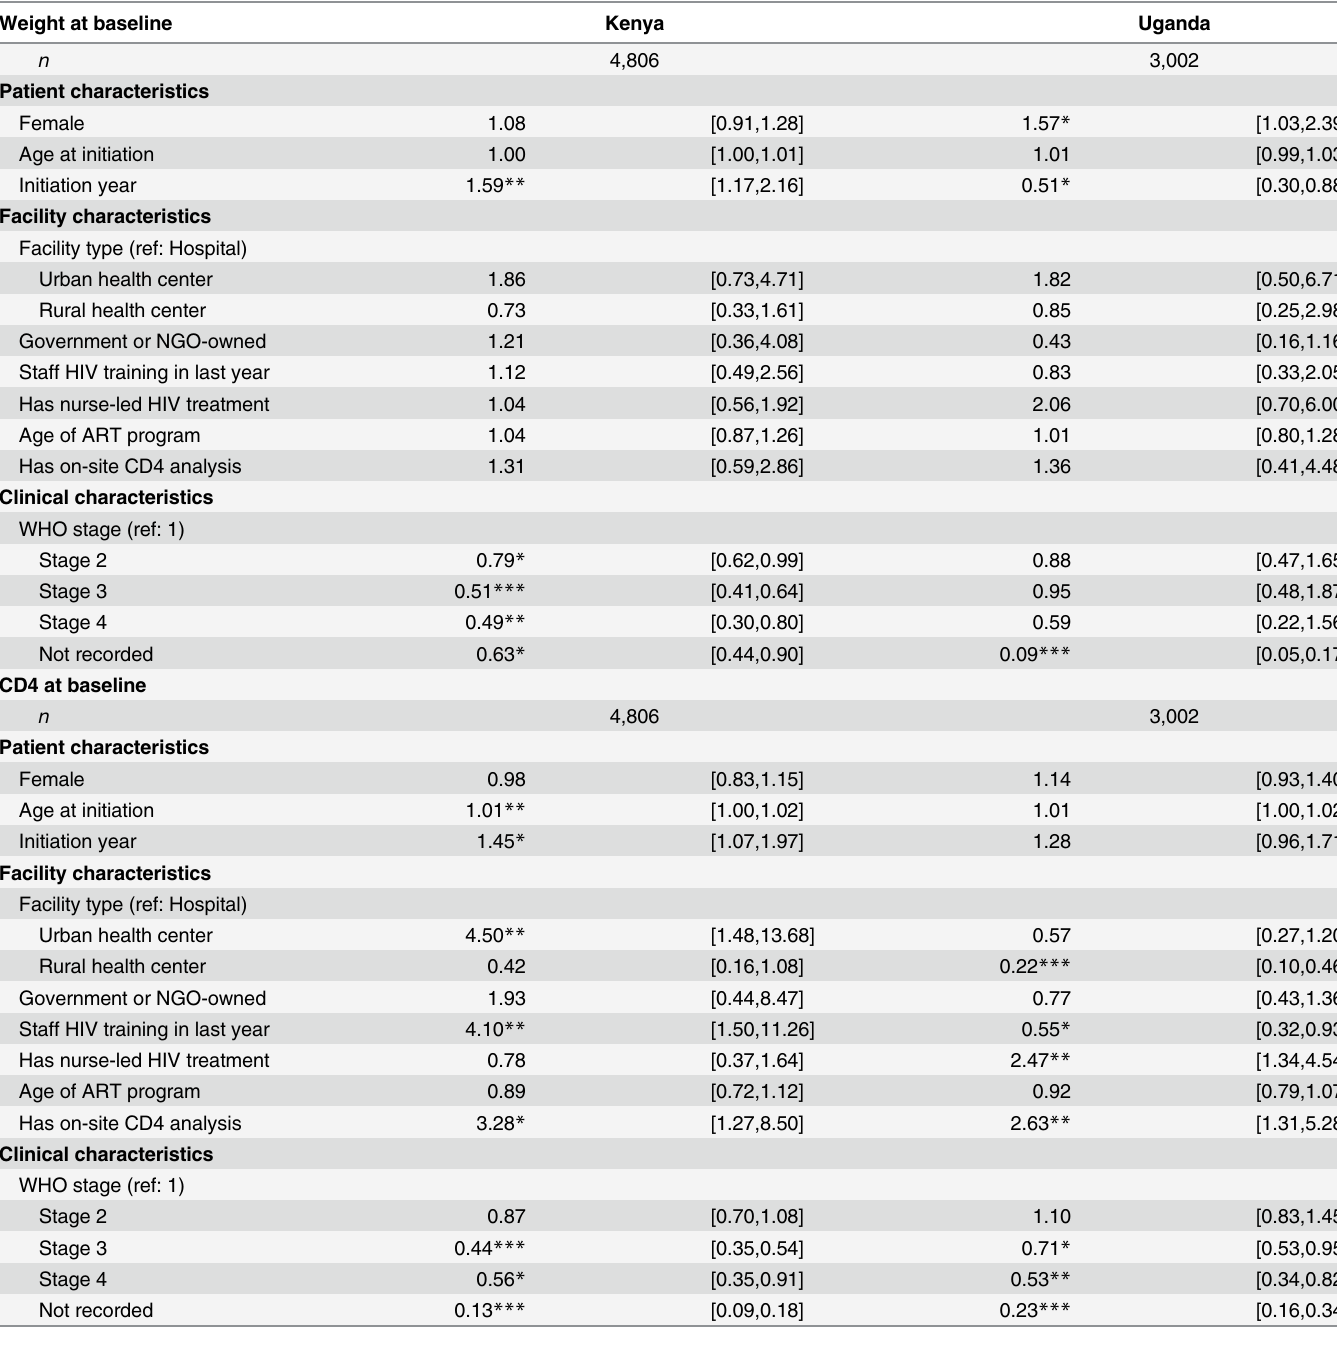
Table 2. Predictors of receiving baseline measurements: mixed effects logistic regression results for patients initiating in 2011 –